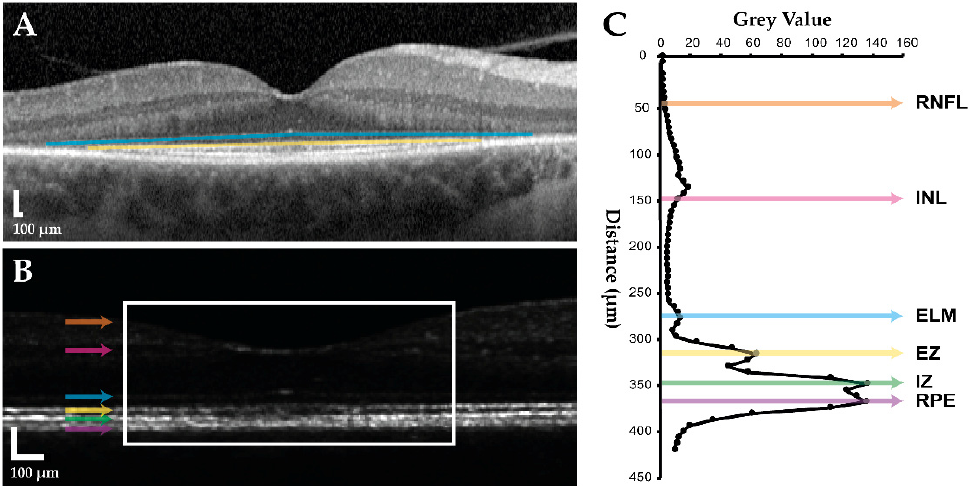
Figure 5. Spectral-domain optical coherence tomography (SD-OCT) image analysis. SD-OCT imaging of the right eye in a 54-year-old female with USH2A -associated non-syndromic retinitis pigmentosa is shown. A horizontal B-scan through the foveal centre is used in ( A ) logarithmic form for outer retinal band width measurement, and ( B ) linear form for longitudinal reflectivity profile (LRP) analysis. External limiting membrane (ELM, solid blue line) and ellipsoid zone (EZ, solid yellow line) widths are measured before B-scan linear transformation, after which an LRP is generated from a 1000 μ m-wide window centred at the foveal pit (white rectangle). Coloured arrows indicate the retinal layers corresponding to peaks in the resulting ( C ) LRP trace: orange, retinal nerve fibre layer (RNFL); pink, inner nuclear layer (INL); blue, ELM; yellow, EZ; green, interdigitation zone (IZ); purple, retinal pigment epithelium